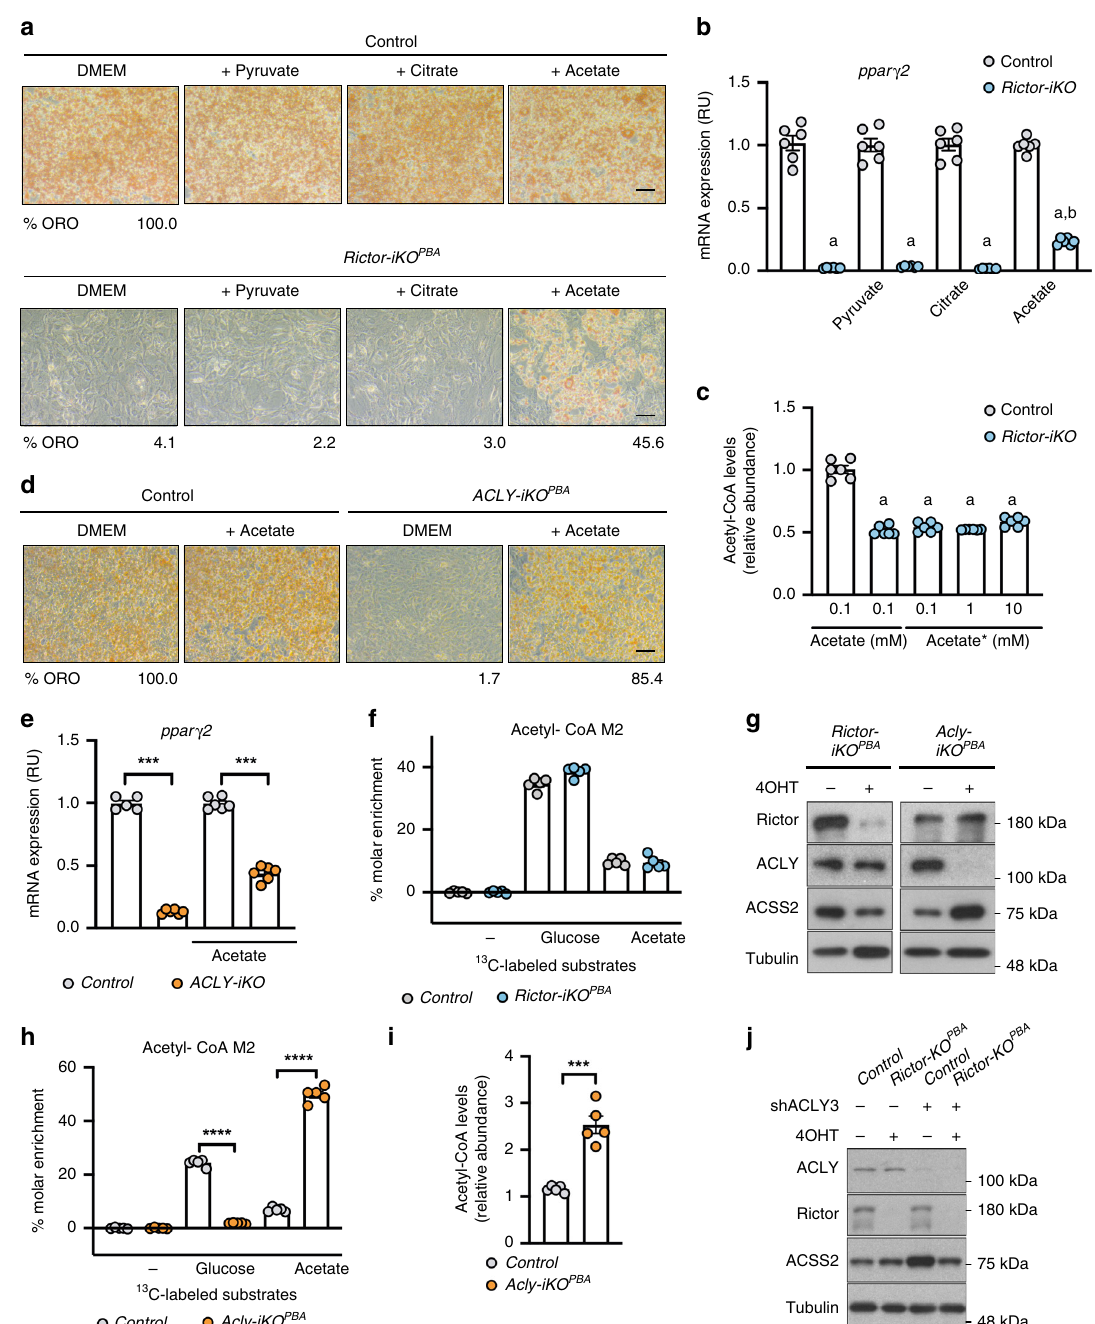
Fig. 5 mTORC2 also regulates acetyl-CoA synthesis from acetate. a , b Isogenic control and Rictor-iKO brown preadipocytes were supplemented with the indicated metabolites during differentiation and Oil Red O (ORO) staining of lipids ( a ) and ppar γ 2 mRNA expression ( n = 6 per group) ( b ) were quanti fi ed as indicators of differentiation ef fi ciency. Percentage of ORO is relative to control in DMEM. Scale bar represents 50 μ m. c Direct acetyl-CoA levels in control and Rictor-iKO PBA cells ( n = 6 per group) supplemented with unlabeled acetate (0.1 mM) or increasing [1,2- 13 C] acetate concentration. d , e Acly- iKO PBA cells were differentiated with or without acetate supplementation followed by Oil Red O (ORO) staining ( d ) and ppar γ 2 mRNA expression ( n = 6 per group) ( e ) analysis. Scale bar represents 50 μ m. f M2 isotopic tracer labeling of total acetyl-CoA levels in Rictor-iKO PBA cells ( n = 5 per group) that were serum deprived for 12 h and then incubated for 1 h with fresh glucose-free DMEM supplemented with 5 mM of labeled [U- 13 C] glucose and 100 μ M